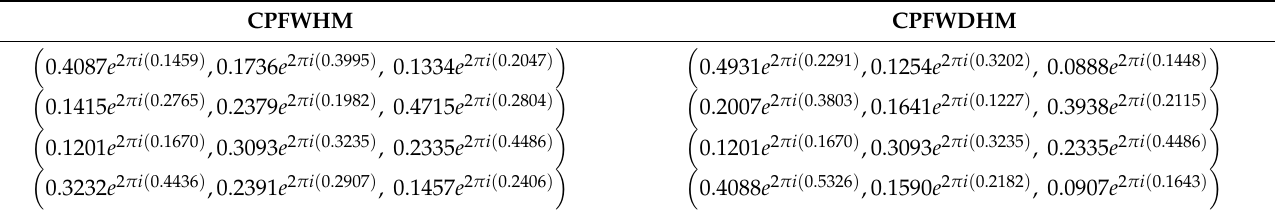
Table 3. Aggregated values by the CPFWHM and CPFWDHM.